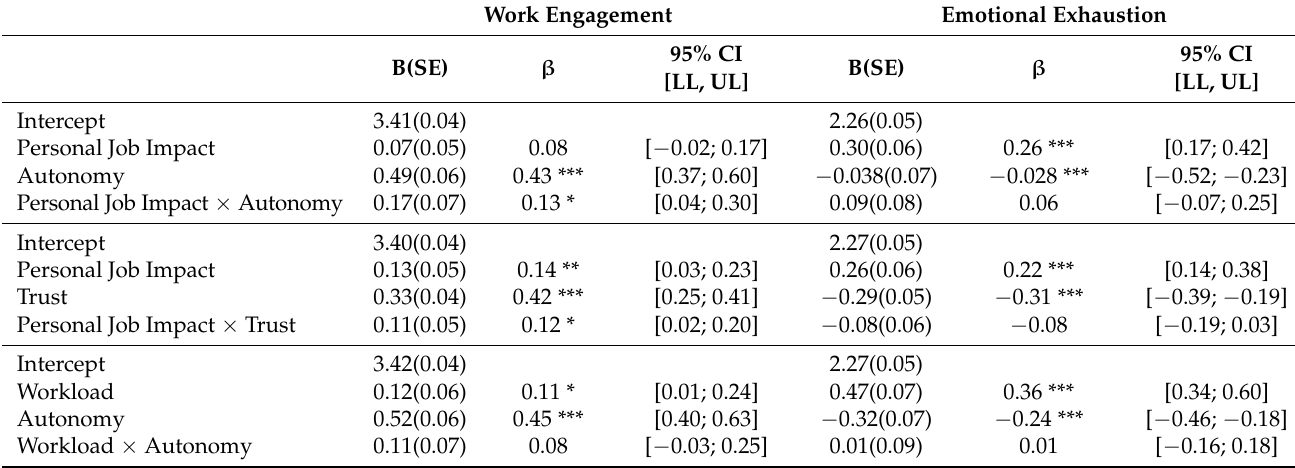
Table 2. Moderator analysis: effects of all variables on work engagement and emotional